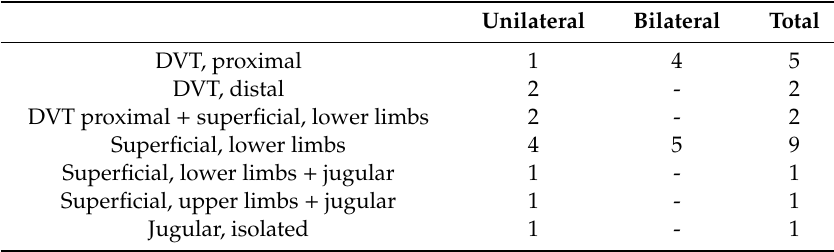
Table 2. Anatomical location of peripheral venous